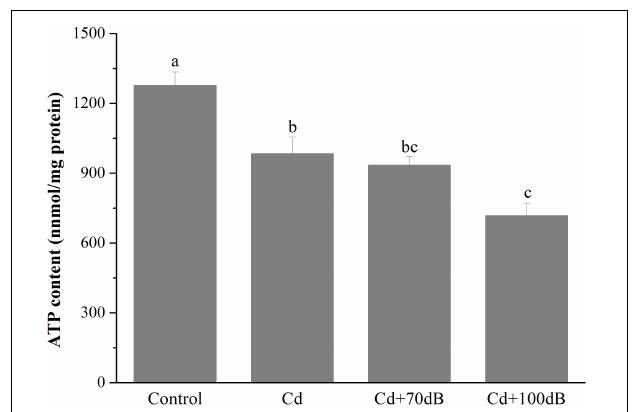
FIGURE 2 | ATP content in the tissues of the blood clams after 10 days of exposure to the control (without Cd and anthropogenic noise), 50 µ g/L Cd, 50 µ g/L Cd + 70 dB re 1 µ Pa anthropogenic noise, and 50 µ g/L Cd + 100 dB re 1 µ Pa anthropogenic noise. Means not sharing the same superscript are significantly